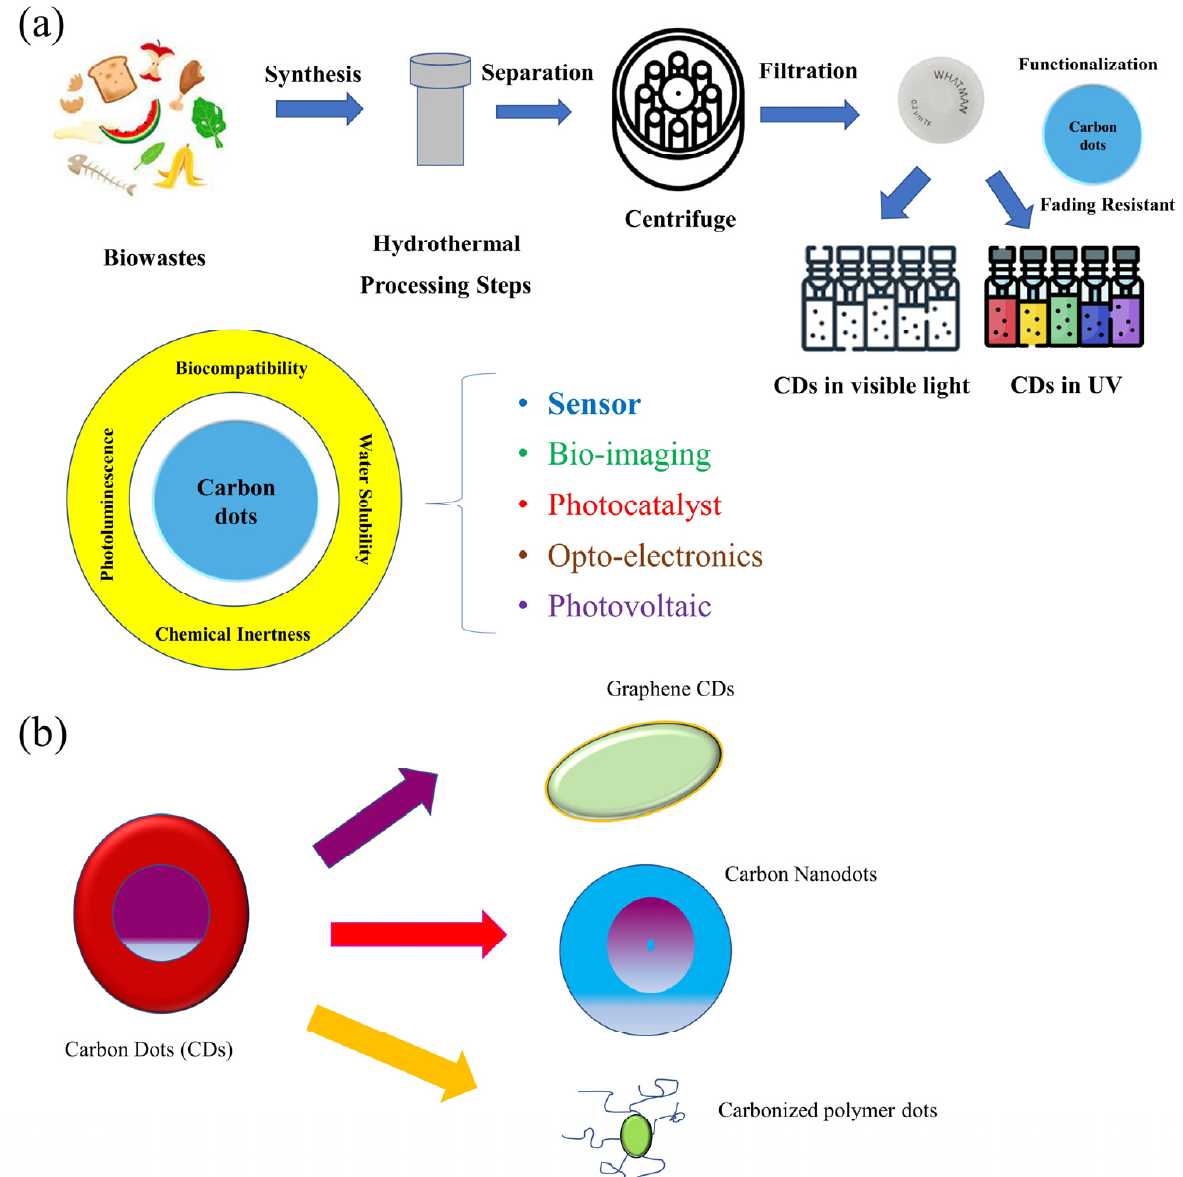
Figure 1. Synthesis techniques ( a ) and types ( b ) of CDs.